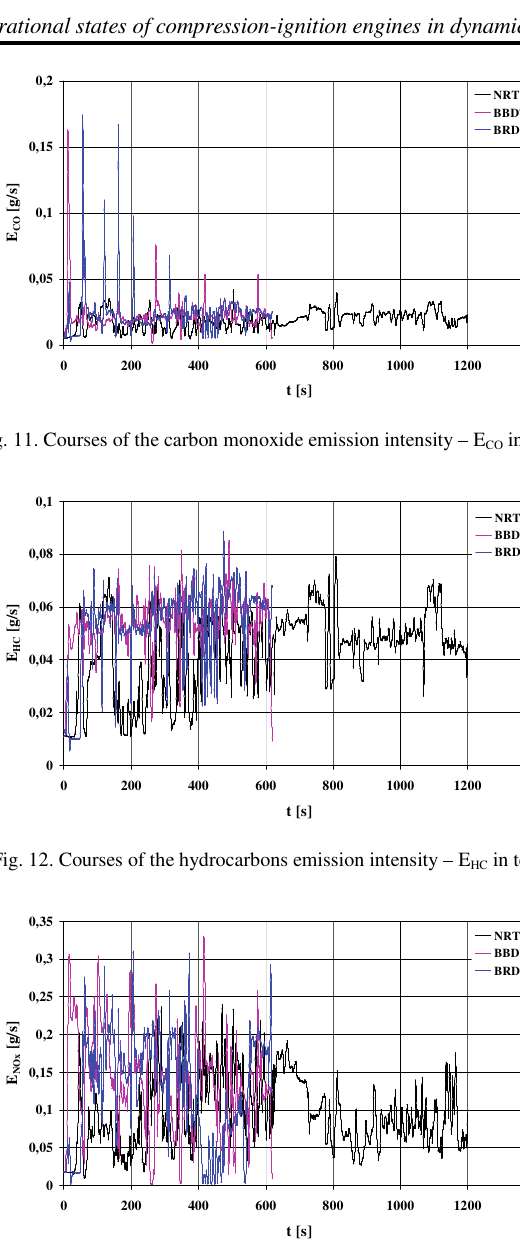
Fig. 13. Courses of the nitrogen oxides emission intensity – E NOx in tests